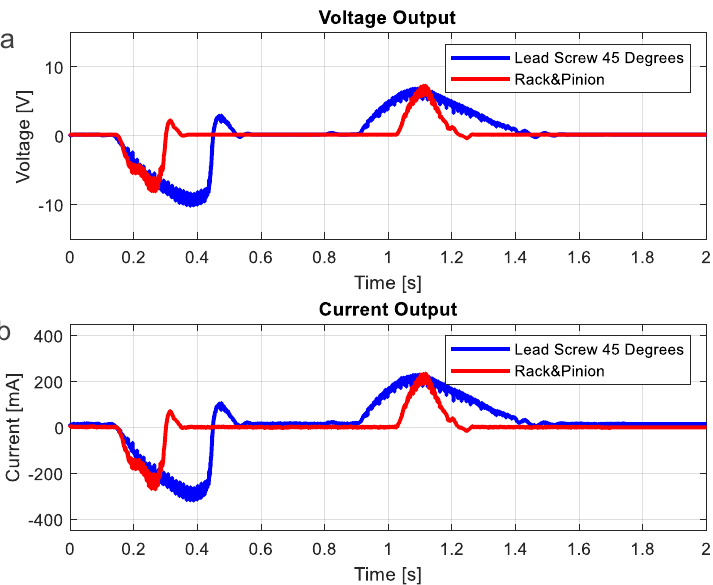
Figure 16. Comparison Voltage and Current of Prototype I and Prototype II. ( a ) Voltage of Prototype I and Prototype II. ( b ) Current of Prototype I and Prototype II. Table 8. Performances of Genpath prototypes I and II.